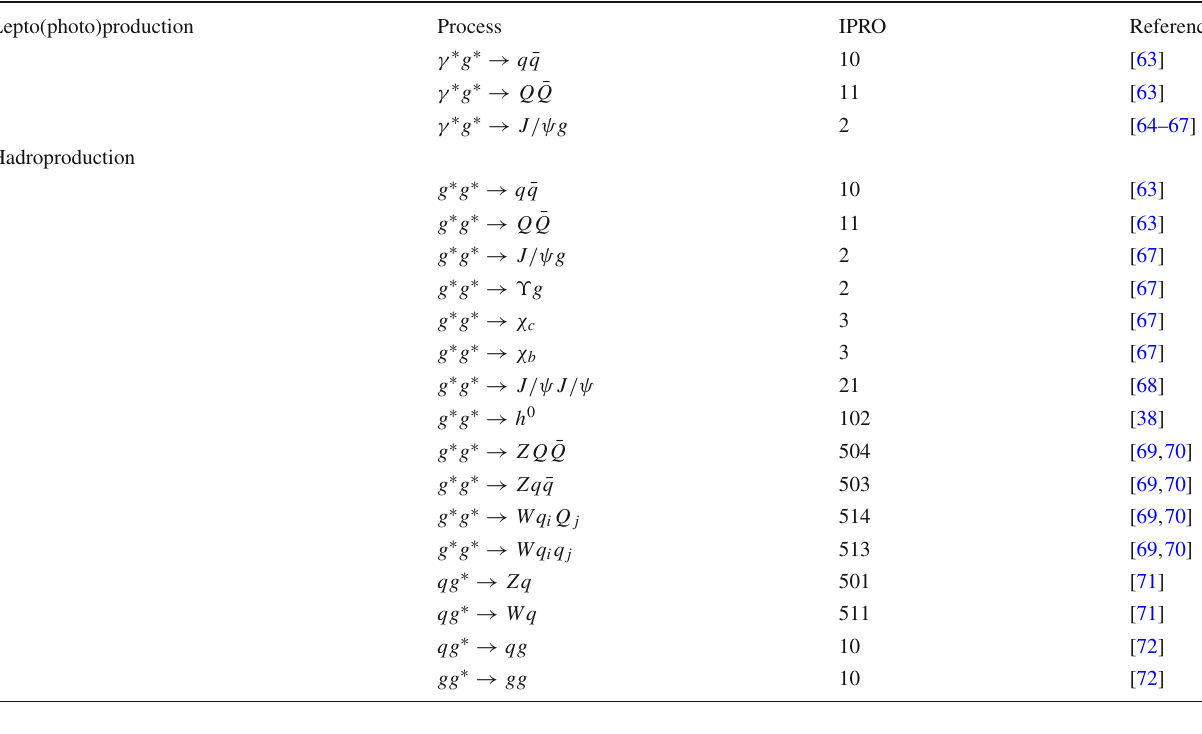
Table 1 Processes included in Cascade3 . Q stands for heavy quarks, q for light quarks Lepto(photo)production Process IPRO